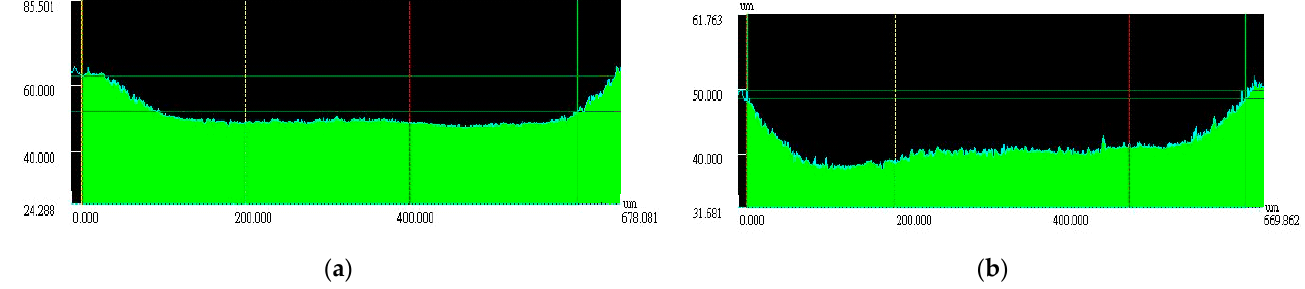
Figure 13. Slot profile by ECM milling along the centerline at the bottom is conducted by a feed rate of ( a ) 30 µm/min, ( b ) 60 µm/min.